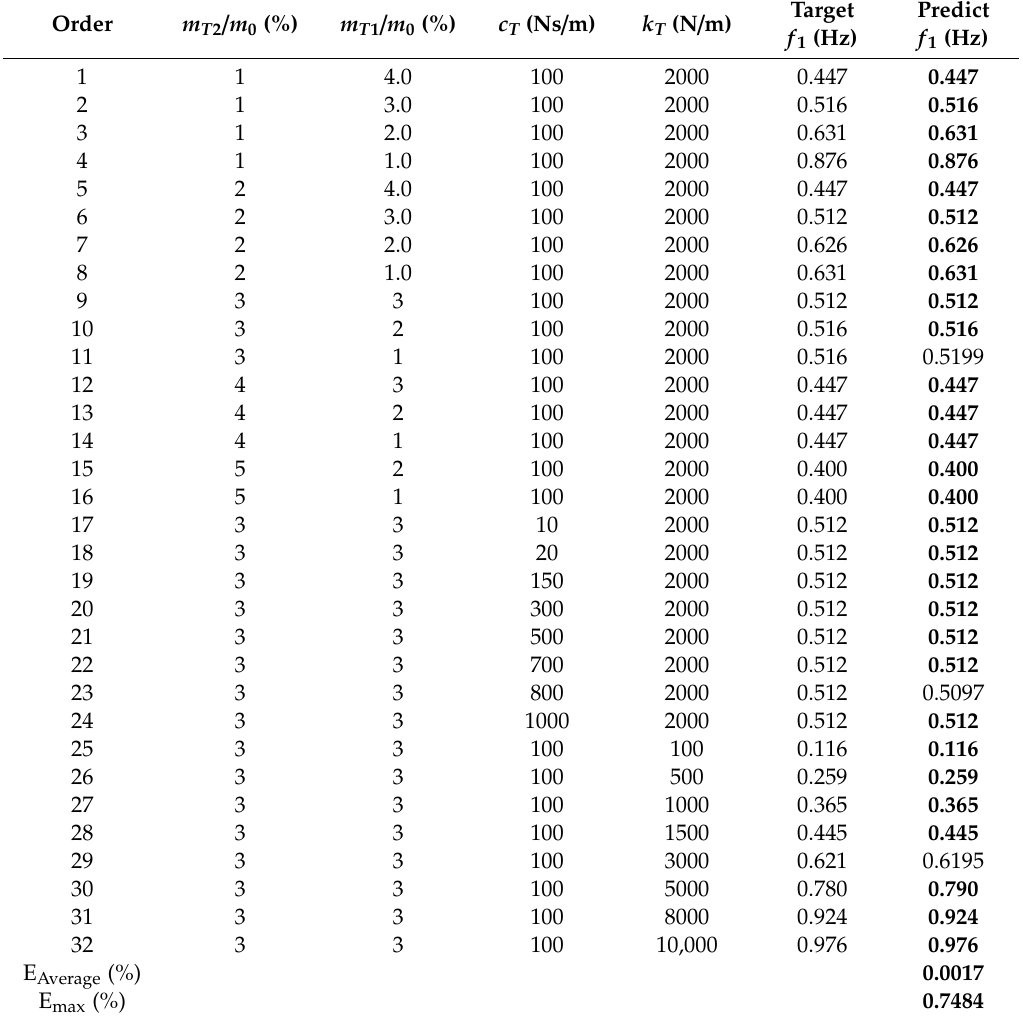
Table 11. The input and output parameters of this artificial neural network (ANN) model for the beam with three